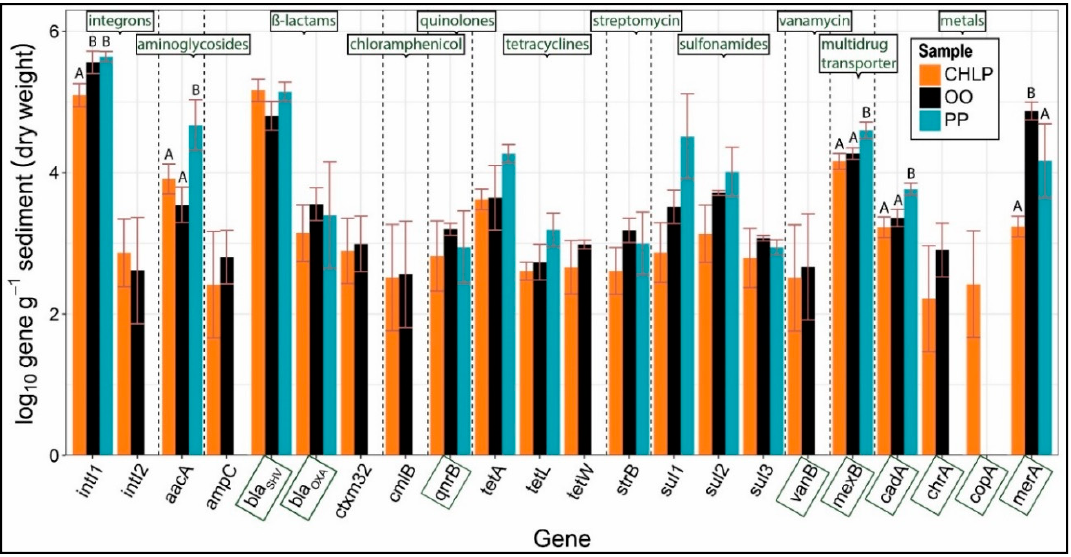
Figure 2. Fluidigm qPCR assay was used to quantify the gene abundance of a suite of metal homeostasis and antibiotic resistance genes with 22 gene successfully quantified. DNA extractions were performed on three separate cores collected at each site, with the standard deviation between these extractions illustrated by the error bars. Letters above the error bars indicate significant differences between the different sediments as calculated by the Tukey HSD test. Along the top of the graph, each gene is divided by dashed lines to the class of antibiotic to which they provide resistance. Genes which were also detected in the GeoChip are highlighted in boxes along the x-axis.